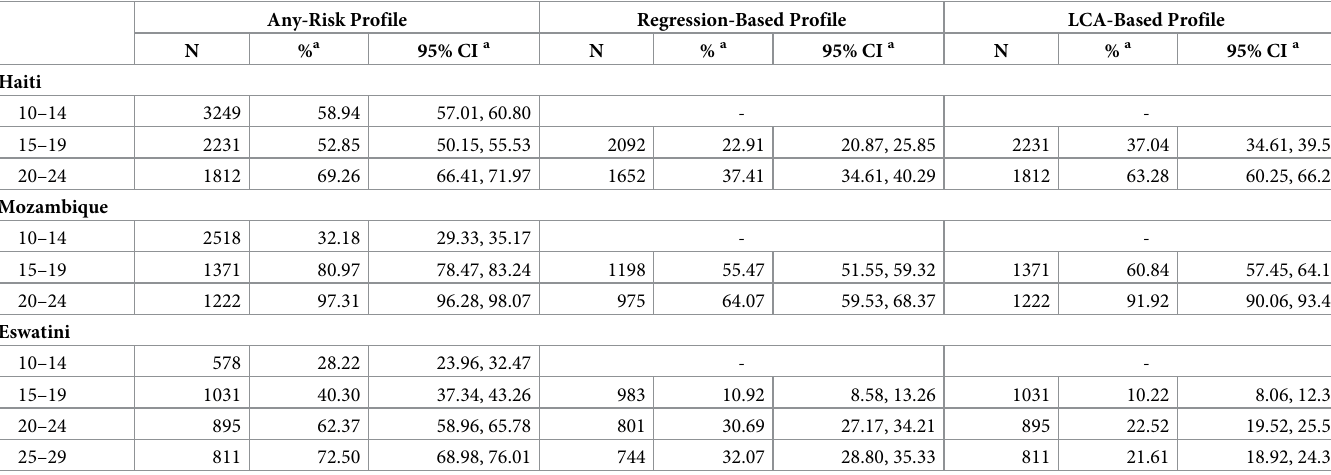
Table 2. Percentage of AGYW who are classified as at-risk of HIV infection, by estimation methodology. Any-Risk